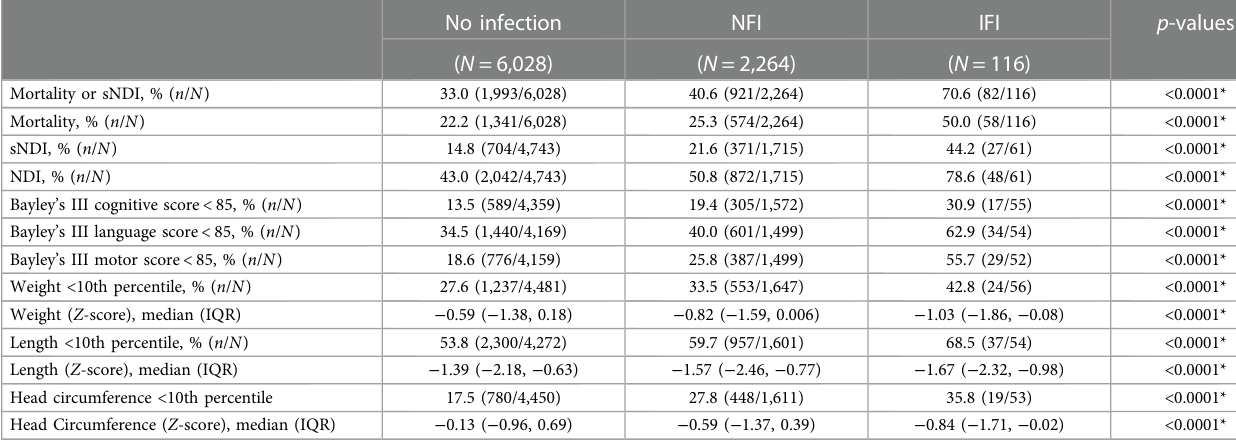
TABLE 3 Comparison of long-term neurodevelopmental outcomes among no infection, infection without invasive fungal infection (NFI) and invasive fungal infection (IFI) groups. No infection